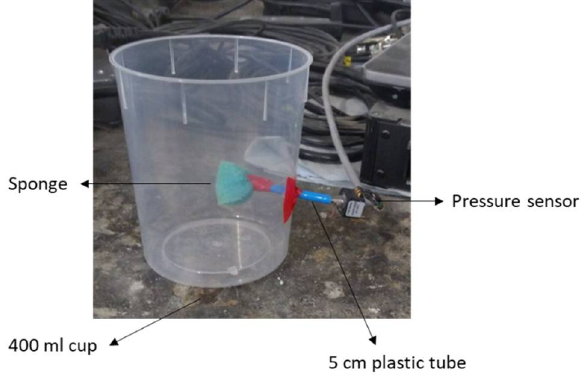
Figure 1. Setup used for the capillary pressure monitoring .